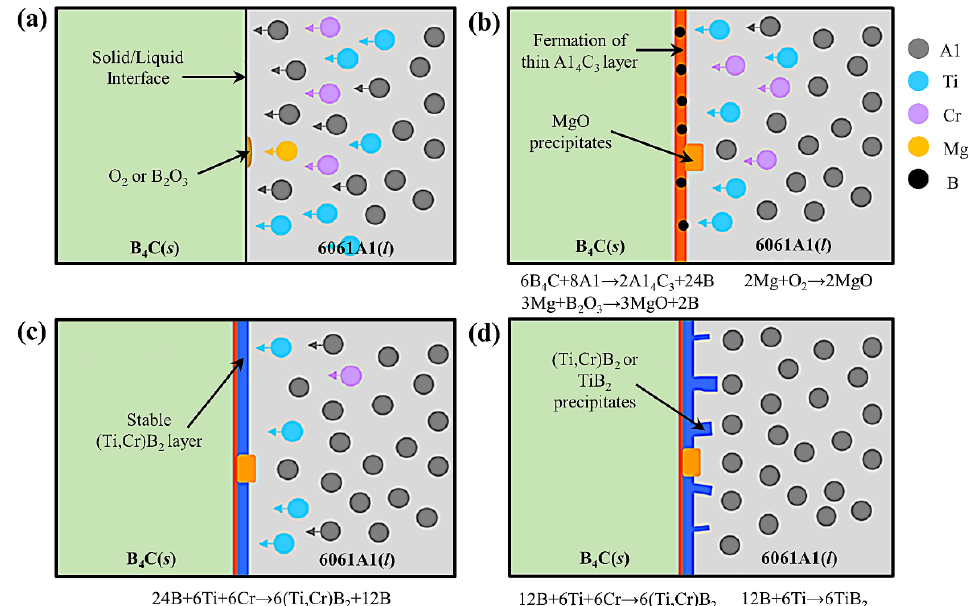
Figure 10. ( a ) Al atoms rapidly diffused toward B 4 C, ( b ) Al 3 BC phase generated at the B 4 C/Al interface, ( c ) (Ti,Cr)B 2 layer was generated on Al 4 C 3 layer and ( d ) TiB 2 or (Ti,Cr)B 2 precipitates were generated on (Ti,Cr)B 2 layer [52].